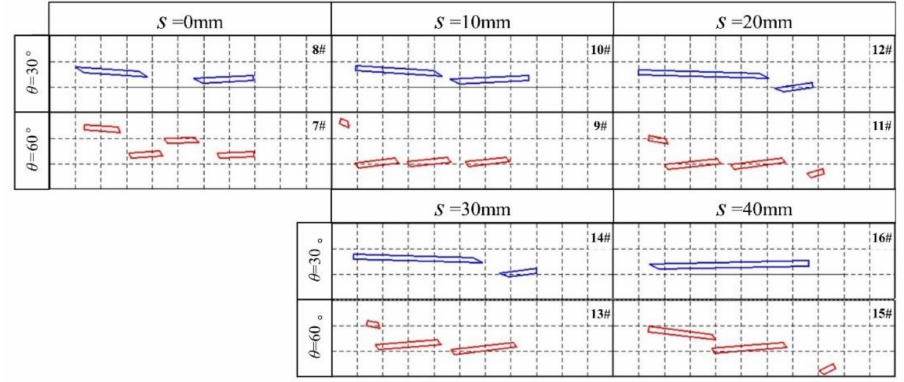
Figure 16. Location pattern of the residual fractured rods after the interaction of long rods with di ff erent interception angles of LEFP and LSC spacing (26